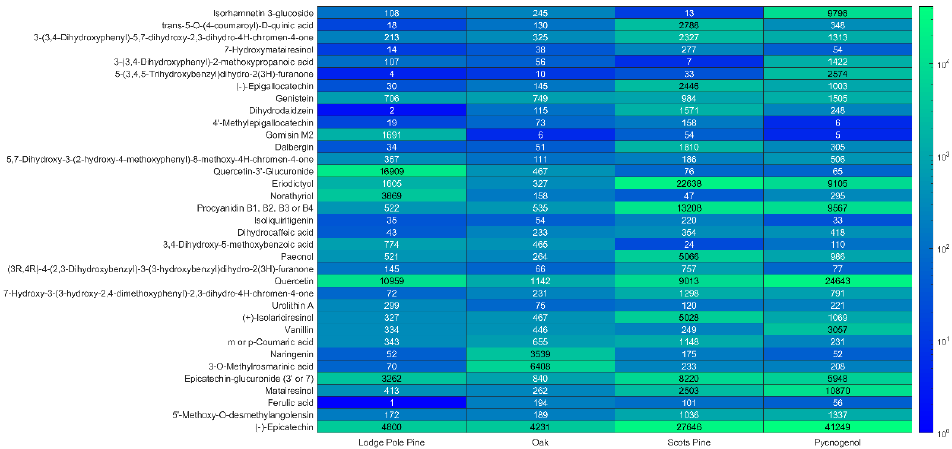
Figure 1. Heat map created using averaged abundances for each sample type across the 35 tentatively identified polyphenols.